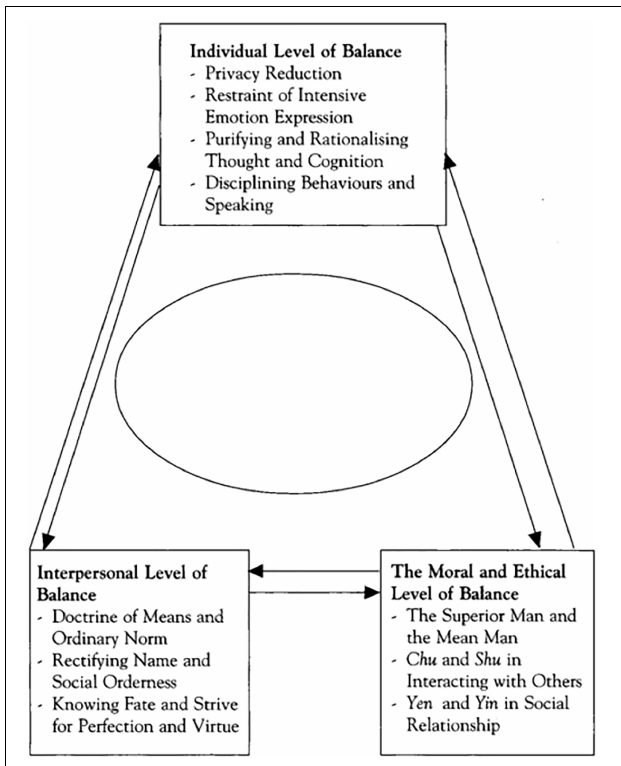
FIGURE 2 | Confucian model of mental